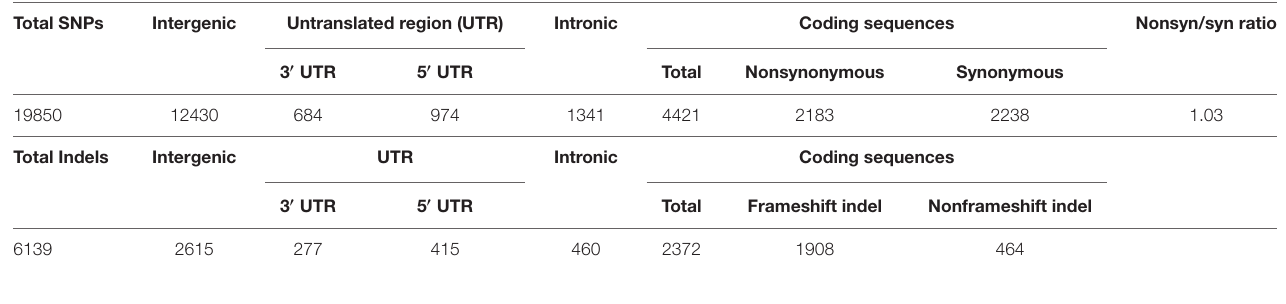
TABLE 1 | Summary of single-nucleotide polymorphisms (SNPs) and indels. Total